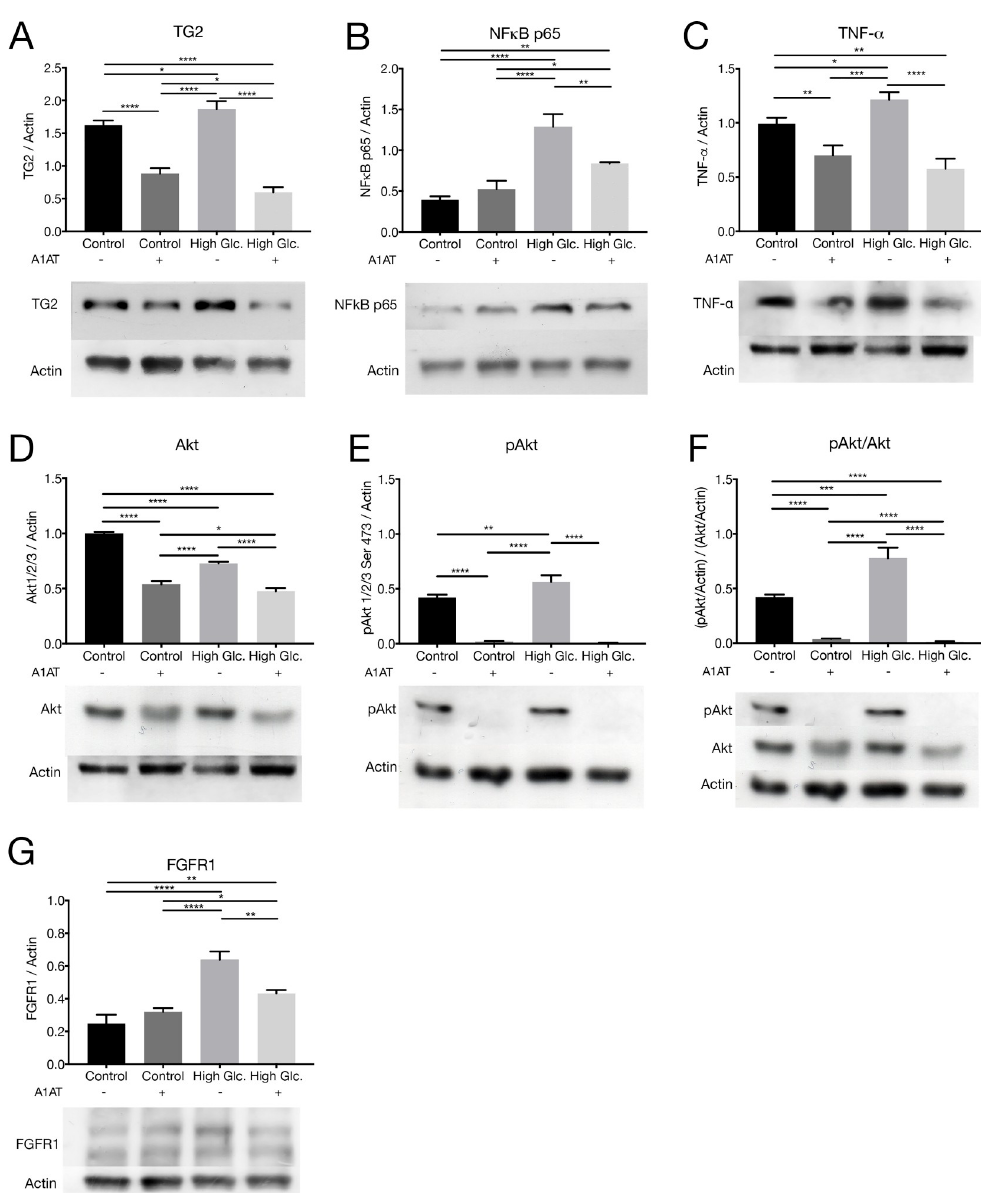
Fig 3. NF κ B pathway under high glucose and with A1AT treatment. Expression of different intermediates of NF κ B pathway was measured by western blot (A) Transglutaminase 2, (B) NF κ B p65, (C) TNF- α , (D) Akt, (E) pAkt, (F) levels of pAkt relativized to Akt, (G) FGFR1. Results were expressed as protein vs. Actin expression mean ± SD. � p < 0.05, �� p < 0.01, ��� p < 0.001, ���� p < 0.0001 vs. Control. Due to the different molecular weight of Akt, TNF- α and Actin, the same PVDF membranes were incubated with the different antibodies, for this reason, Actin band pattern is repeated between Akt and TNF- α . In pAkt/Akt ratio Akt Actin was choosen to display as an example, pAkt was relativized to its actin and the same procedure was done to Akt, then pAkt/Actin was relativized to Akt/Actin. The actin and Akt bands in (E) and (F) are almost identical.